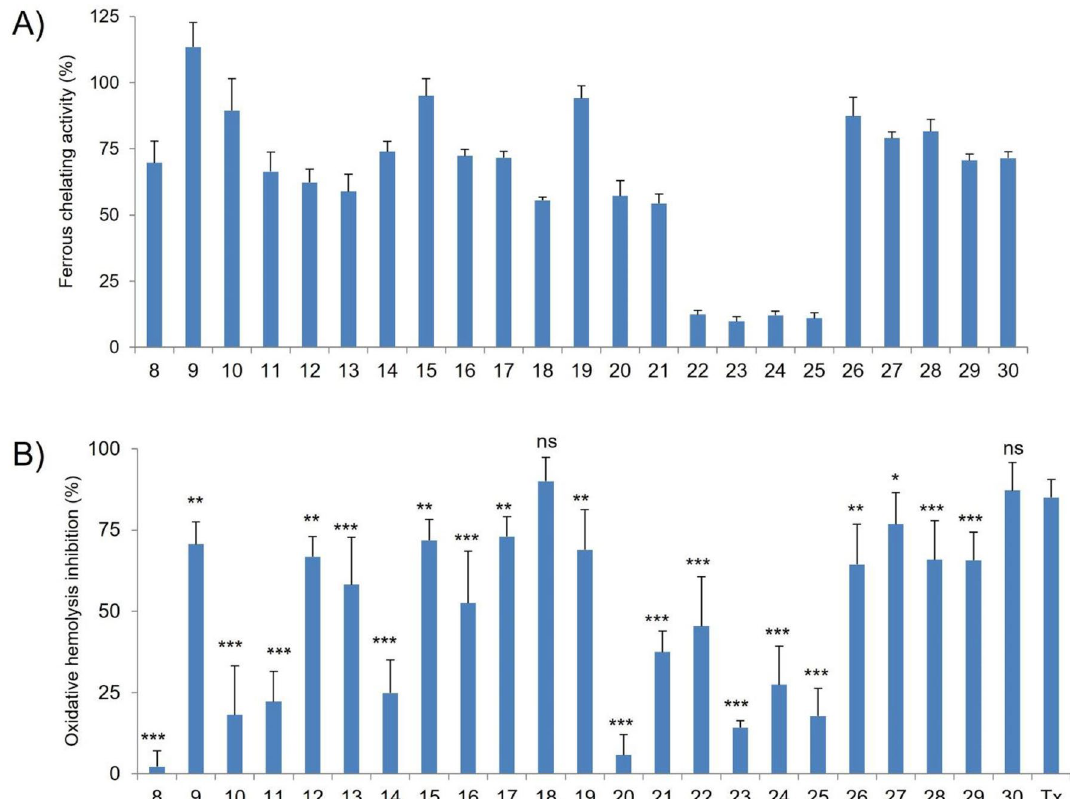
Figure 2. ( A ) The ferrous chelating activity of caffeine derivatives at 0.1 mg/mL presented as % activity of the standard chelator EDTA. The results are presented as mean value ± standard deviation. ( B ) In vitro protective activity of caffeine derivatives and standard antioxidant Trolox (Tx) at concentration of 0.1 mg/mL against AAPH-induced oxidative hemolysis. RBC were pre-incubated (20 min) with compounds and incubated (240 min) with 60 mM AAPH. The results are presented as the mean value ± standard deviation in comparison with Tx activity (* P < 0.05, ** P < 0.01, *** P < 0.001). Non statistically significant difference is indicated as